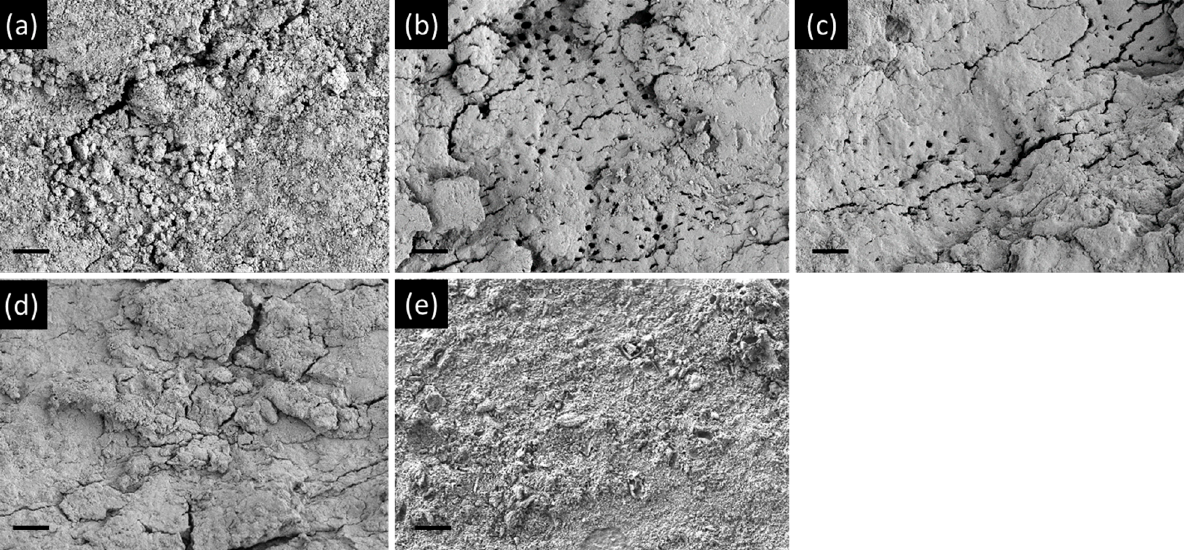
Figure 3. Morphology of E. faecalis biofilms formed in the bovine root canal observed by FE-SEM: ( a ) control; ( b ) PZBS; ( c ) Ultracal; ( d ) Calasept; ( e ) Calcipex II. Scale bar = 10 μ m.